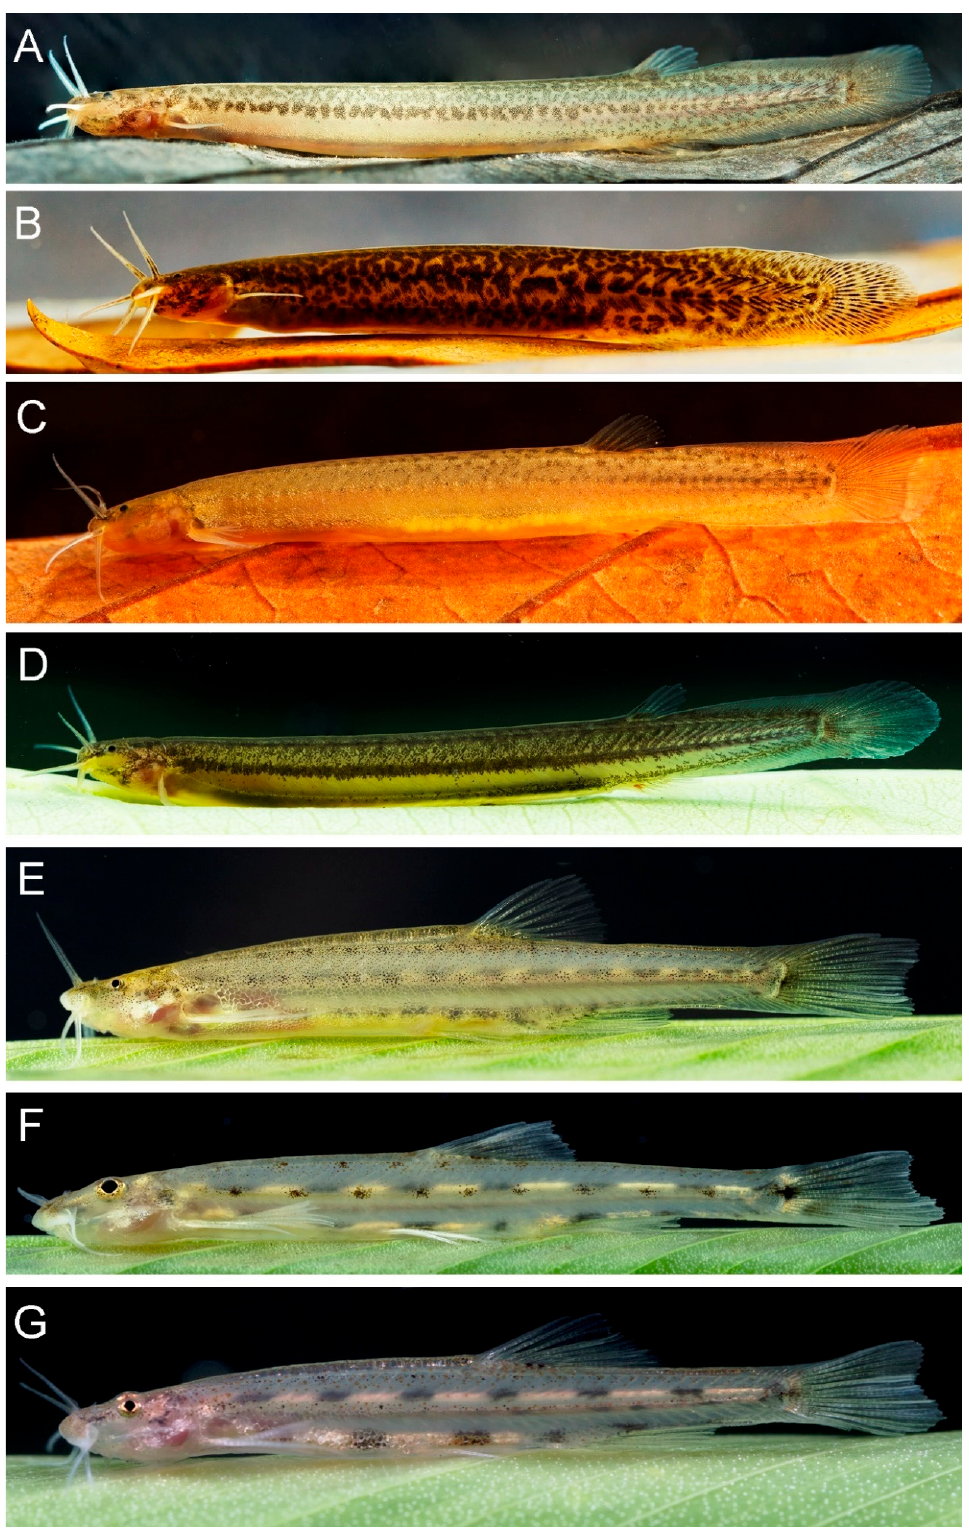
Figure 6. Live specimens of the Microcambevinae, lateral view: ( A ) Listrura ( Prolistrura ) camposi , UFRJ 11404, 36.4 mm SL; ( B ) Listrura ( Prolistrura ) depinnai , UFRJ 12552, 33.9 mm SL; ( C ) Listrura ( Paralistrura ) tetraradiata , UFRJ 11458, 35.1 mm SL; ( D ) Listrura ( Listrura ) macacuensis sp. nov., UFRJ 12669, holotype, 29.8 mm SL; ( E ) Microcambeva ( Trichocambeva ) filamentosa , UFRJ 12187, holotype, 31.4 mm SL; ( F ) Microcambeva ( Pterocambeva ) ribeirae , UFRJ 12189, 33.3 mm SL; ( G ) Microcambeva ( Microcambeva ) barbata , UFRJ 12185, 20.4 mm